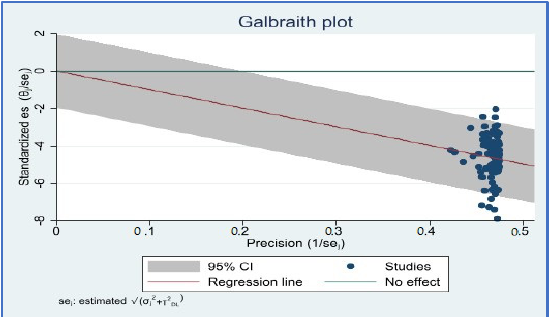
Figure 3. Galbraith plot of reviewed studies.